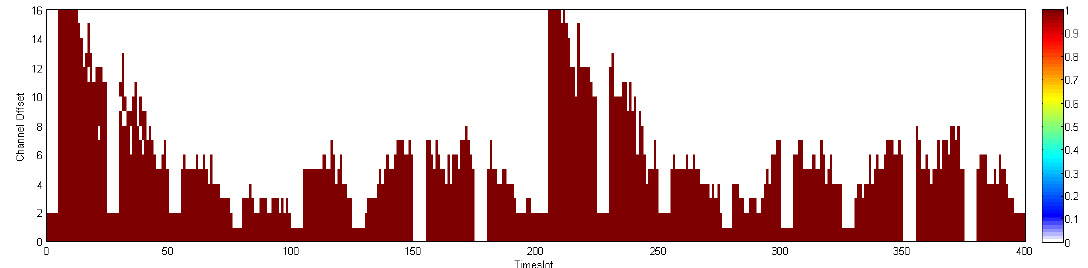
Figure A8. Communication schedule of WirelessHART network with 17 nodes per one-hop neighborhood.